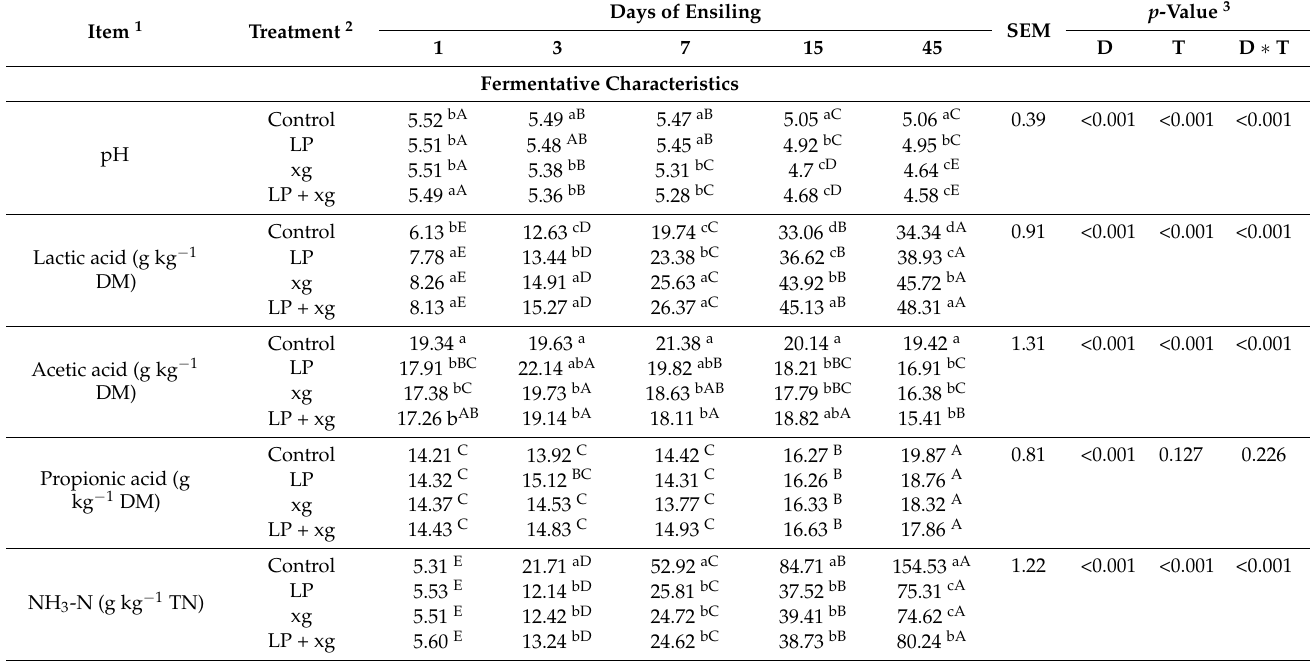
Table 2. Changes in fermentative characteristics during the ensiling of low-moisture content Stylosan- thes